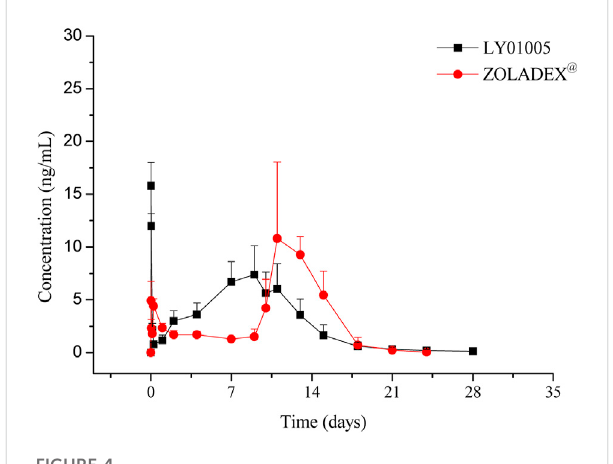
FIGURE 4 Mean plasma concentration-time pro fi les of LY01005 and Zoladex ® in